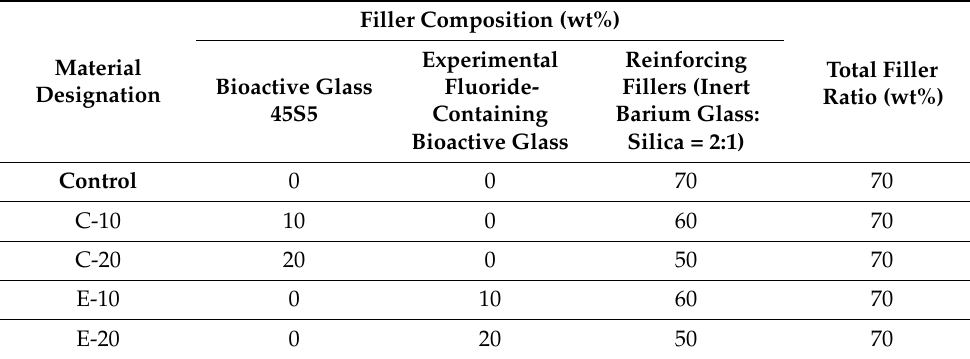
Table 2. Composition of experimental